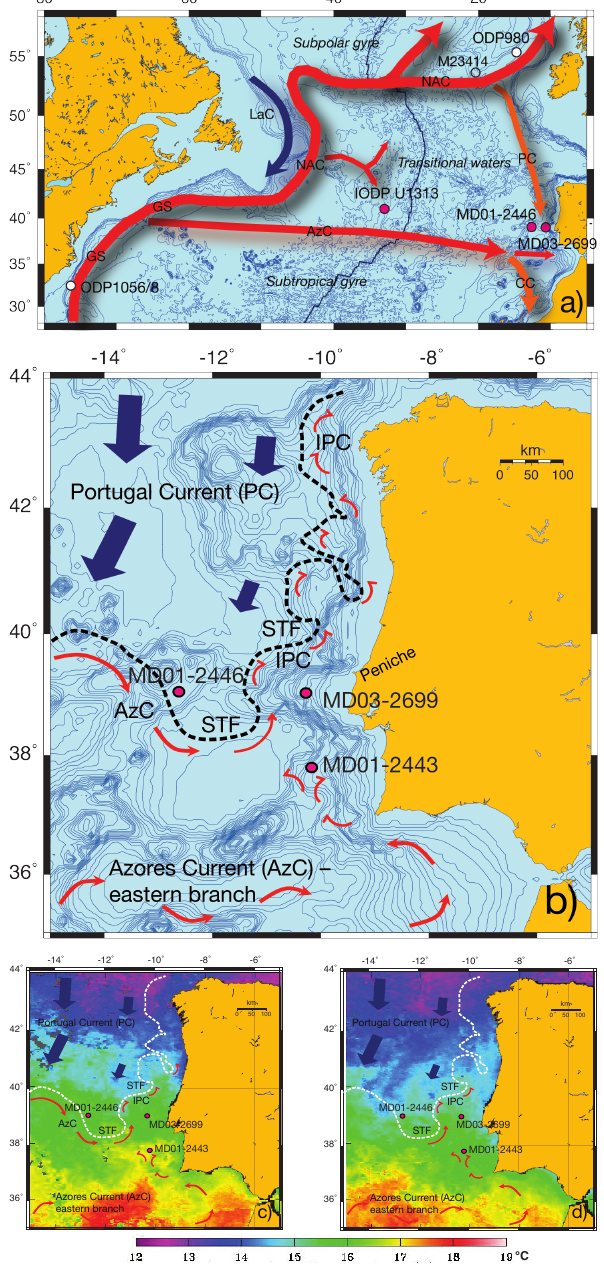
Fig. 1. (a) Core locations and major surface water currents in the North Atlantic (Fratantoni, 2001): GS=Gulf Stream; NAC=North Atlantic Current; AzC=Azores Current; CC=Canary Current; PC=Portugal Current; LaC=Labrador Current. (b) Winter circula- tion scheme off Portugal after Peliz et al. (2005) with IPC=Iberian Poleward Current and STF=Subtropical front. (c) and (d) Satel- lite derived sea surface temperatures (AVHRR Pathfinder Version 5; http://poet.jpl.nasa.gov) for January 2002 (c) and February 2007 (d) (monthly means) for the Iberian margin – both cases with the IPC present – indicate that temperature gradients between the three sites can vary between 0 and 1.5 ◦ C. Currents and fronts, if depicted, as in